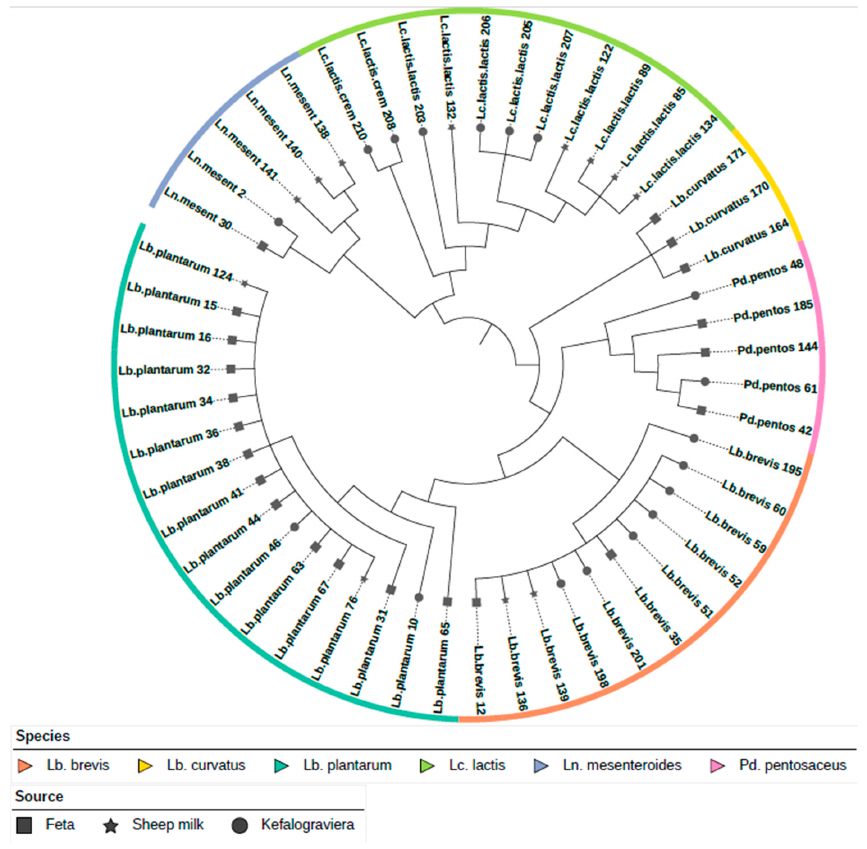
Figure 2. Phylogenetic tree of the 51 LAB isolates. The colored ring indicates the isolates’ species according to the legend. Symbols at the tree’s leaves denote the isolation source of each isolate according to the legend.